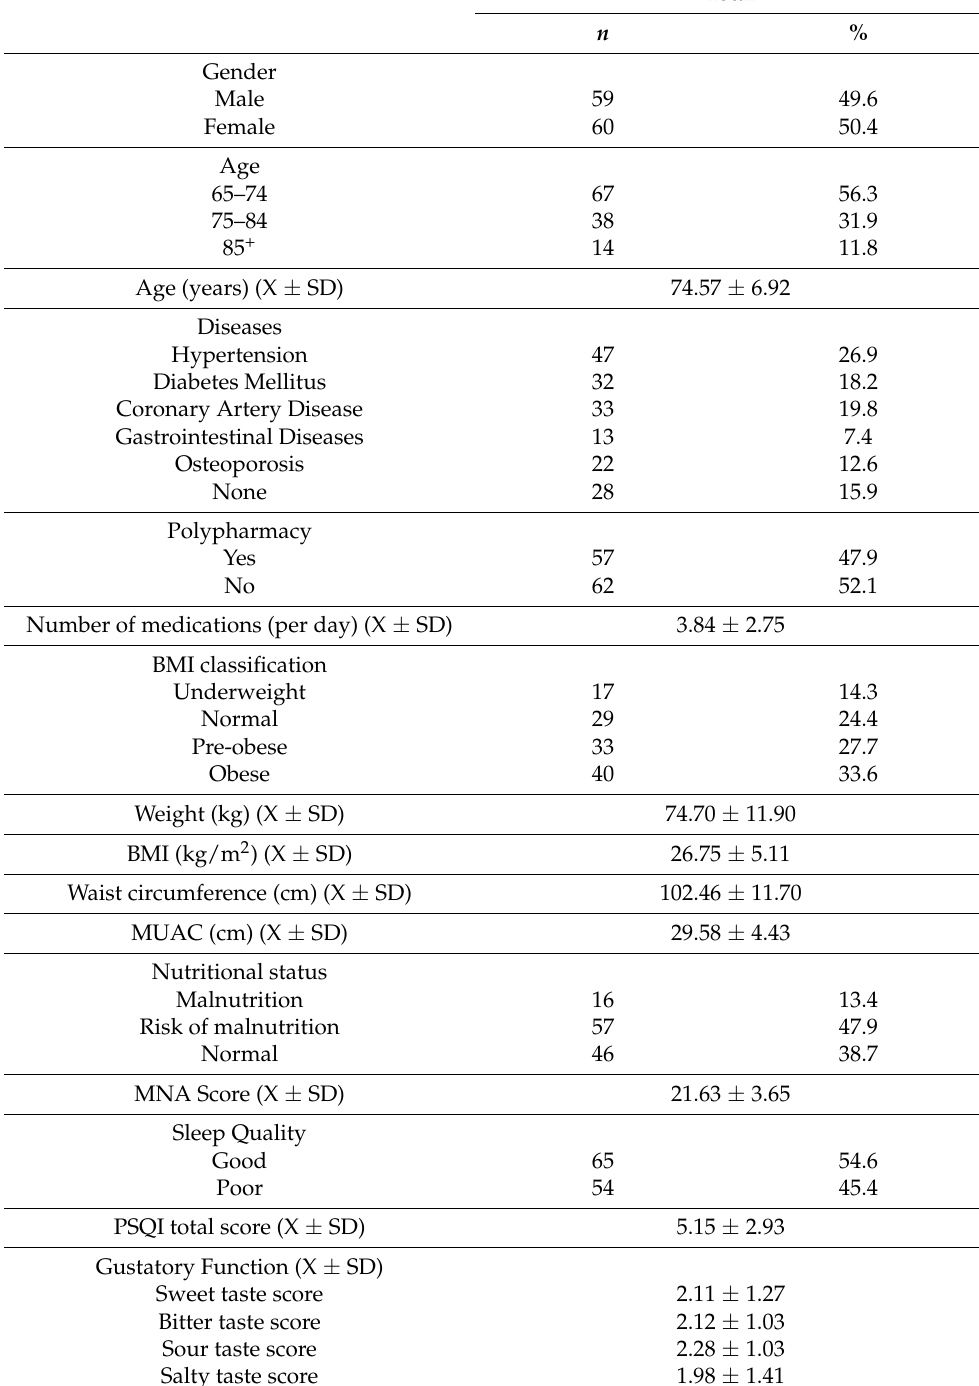
Table 1. General characteristics of the